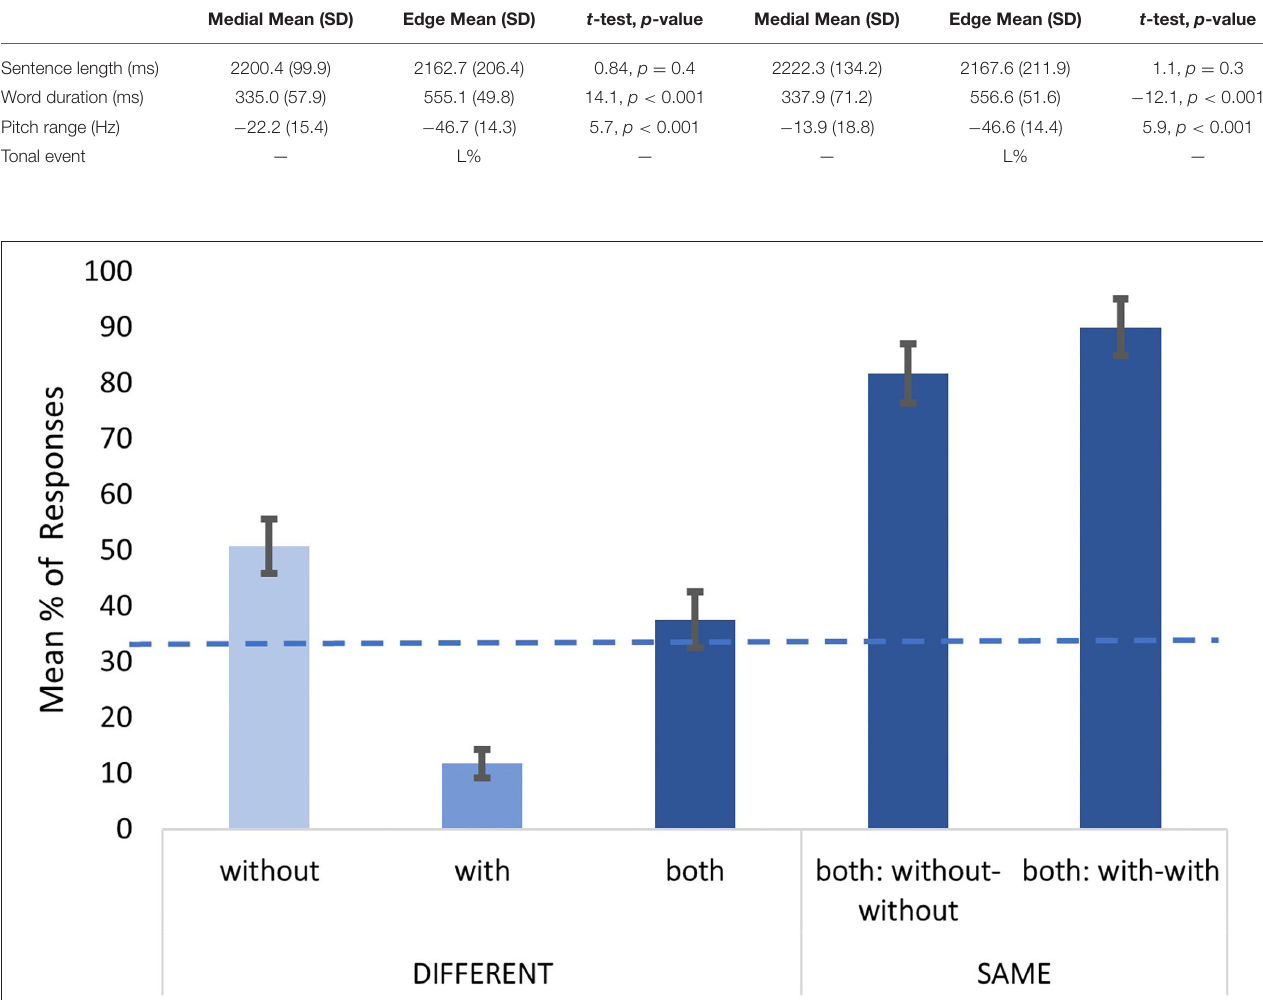
0.001]. Specifically, the participants were choosing utterances without the mask as more intelligible in 50.7% of the trials (against a chance level of 33.33%). Similarly, for the same trials, the participants were choosing both over 80%, suggesting that the participants correctly observed no difference between without-without, and with-with pairs. A Mixed-model analysis in lmerTest package (Kuznetsova et al., 2017) in R (R Core Team, 2020) on reaction time for different pairs is in line with response distribution. The participants were fastest when choosing without (M = 2449.1 ms; set as a reference), in comparison to with ( ß = 103.5, SE = 21.8, t = 4.7, p < 0.001), and both ( ß = 131.5, SE = 31.4, t = 4.1, p < 0.001). Reaction time did not differ between with and both ( t = − 0.8 , p =